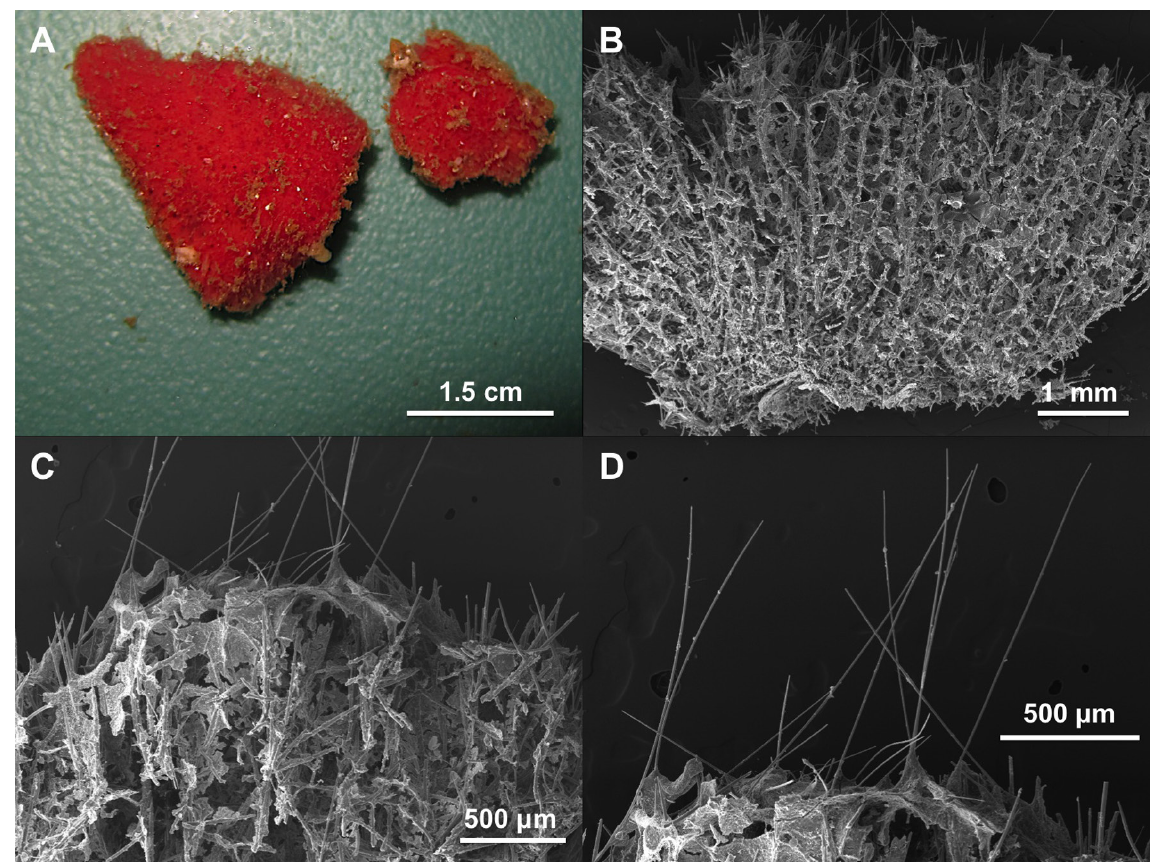
Fig. 11. Biemna typica Bertolino, Costa & Pansini sp. nov., holotype (CILE 28; MSGN 61495). A . The holotype in life. B . Plumose skeleton. C–D . Ectosomal